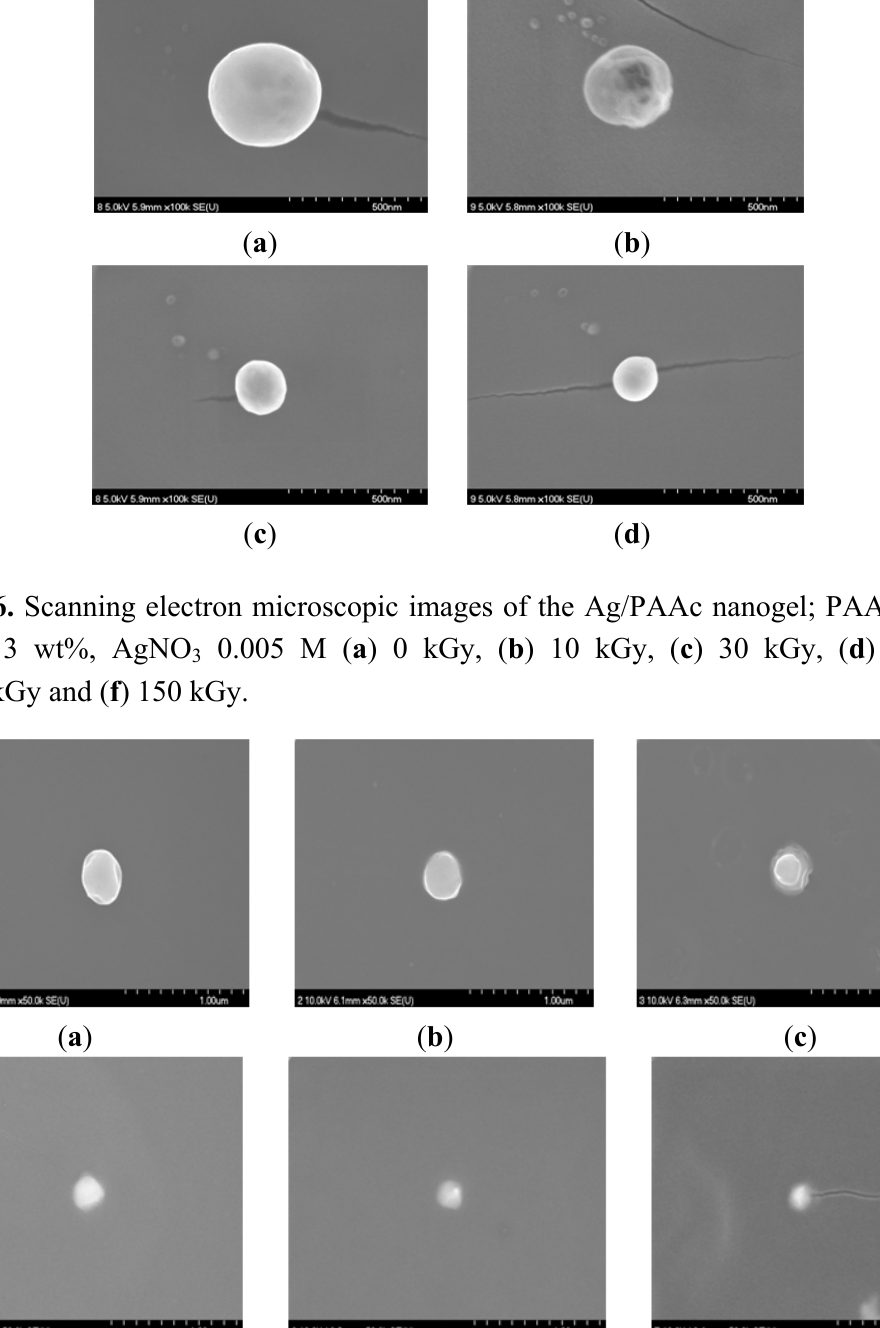
Figure 5. Scanning electron microscopic images of nanogels; PAAc 1 wt%, hexane 3 wt%